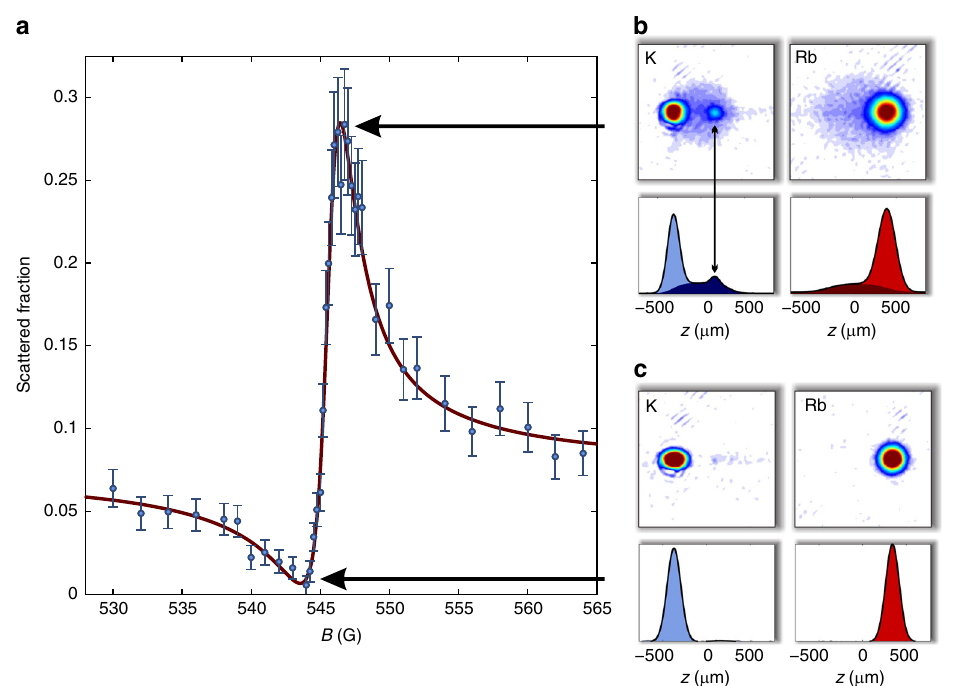
Fig. 3 Imaging and analysis of 40 K + 87 Rb collisions. a Measured scattered fraction (circles) as a function of magnetic fi eld for E / k = 52(1) μ K; error bars indicate one standard deviation uncertainties. Solid line is a fi t to Eqs. (5) and (6). b , c Absorption images and density pro fi les of K ( b ) and Rb ( c ) acquired at the magnetic fi elds indicated by the horizontal arrows. Light blue and light red coloured areas in density pro fi les indicate unscattered atoms and dark red and dark blue areas indicate scattered atoms. The double-headed arrow in b indicates an additional 40 K feature (see text and Supplementary Fig.